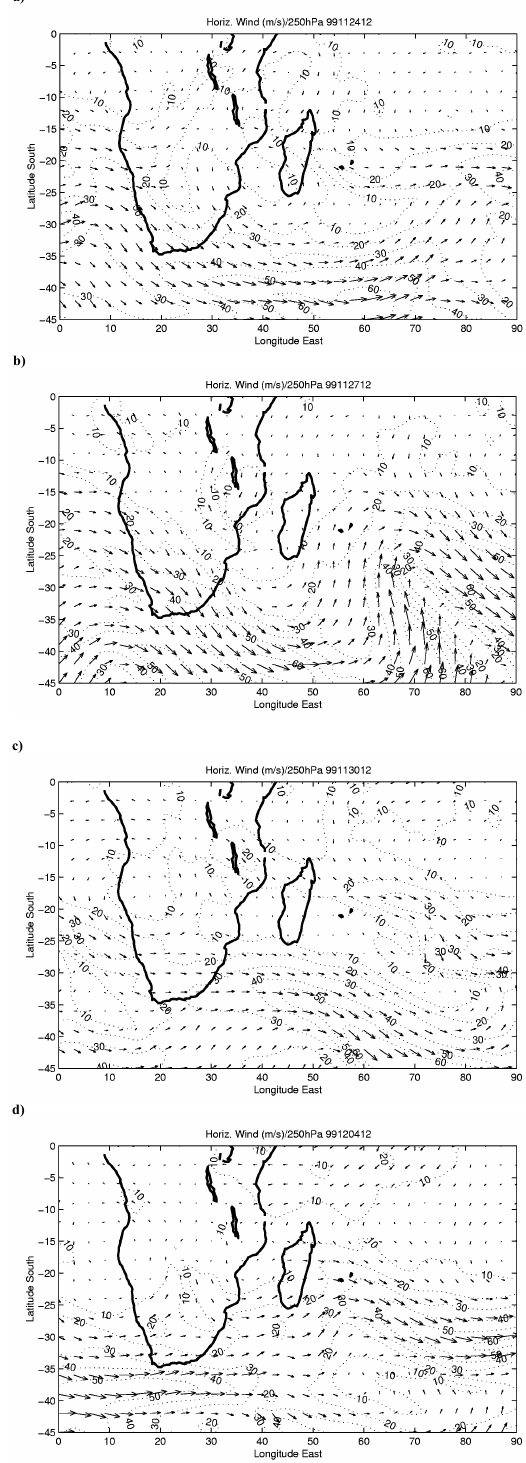
Figure 2 (continued) Fig. 2. Wind fields at 250 hPa from ECMWF data showing